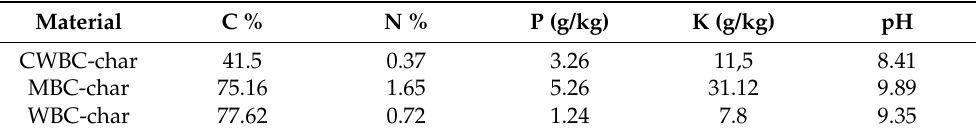
Table 2. Characterization of